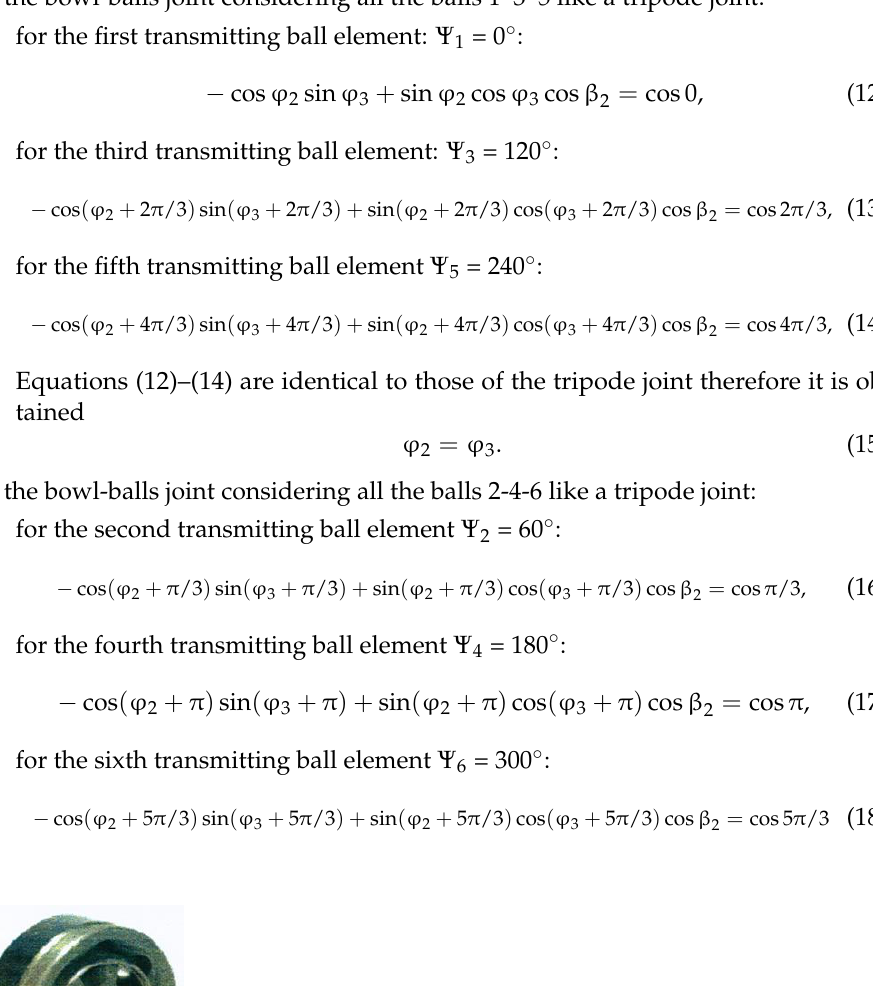
Figure 8. Components of the bowl-balls joint. 4. Nonuniformity of Geometric vs. Kinematic Isometry of Driveshafts and Discussions The relations that express the nonuniformity of the kinematic isometry of driveshafts can be obtained from the general formulation found by Dudita and Diaconescu [5] for an input driving shaft with